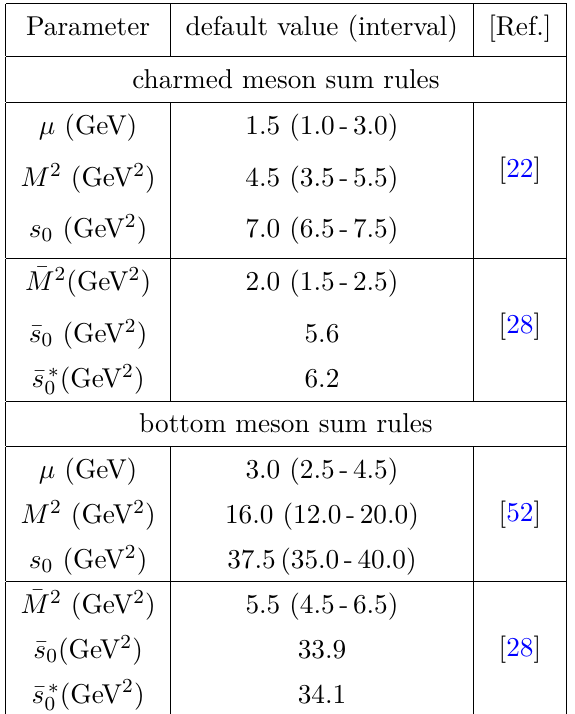
¯ M 2 and duality thresholds s 0